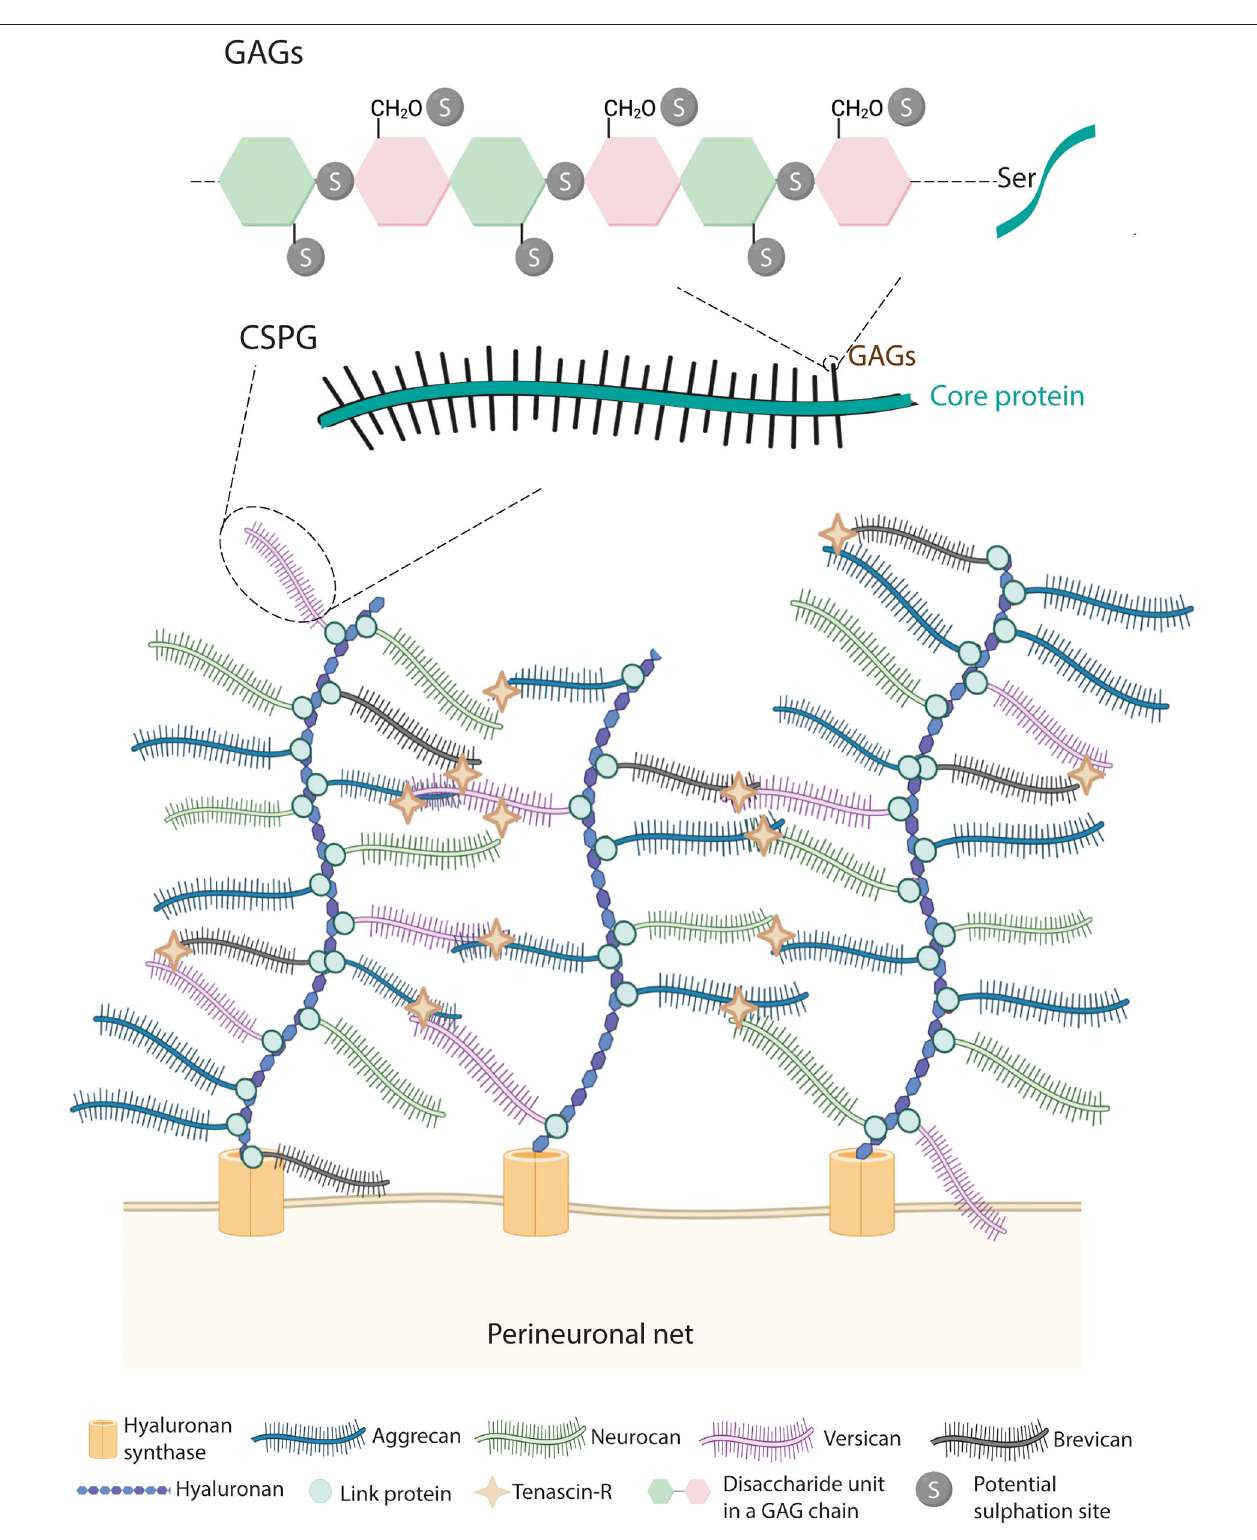
FIGURE 2 | Structure of PNNs. PNNs are composed by hyaluronan, link proteins, chondroitin sulfate proteoglycans (CSPGs) and tenascin-R. Hyaluronan, secreted by the hyaluronan synthase (HAS), binds to members of the lectican family of CSPGs (i.e., aggrecan, brevican, versican, and neurocan) via link proteins. Then, tenascin-R further cross-links lecticans generating a lattice-like structure. CSPGs are formed by a core protein in which GAGs are covalently attached through serine residues. GAGs are composed of disaccharide units of chondroitin sulfate chains, which can be sulfated at the 2nd, 4th, and 6th positions.